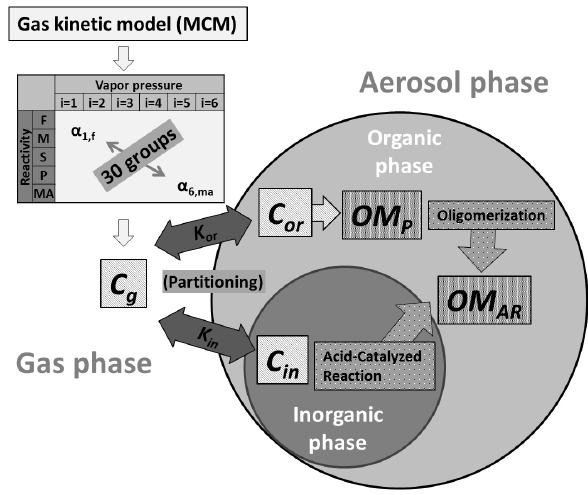
Fig. 1. Conceptual structure of the UNIPAR model. α i,j is the mass-based stoichiometric coefficient. Reactivity F, M, S, P and MA indicate the fast, medium, slow, nonreactivity and multi-alcohol lumping group, respectively. C and K denote the concentration (µgm − 3 of air) of lumping species and the partitioning coeffi- cient (m 3 µg − 1 ), respectively. Subscripts “g”, “or”, and “in” de- note gas, organic, and inorganic aerosol phases, respectively. OM P and OM AR are the concentrations (µgm − 3 ) of organic matter (OM) produced by partitioning and aerosol-phase reactions,